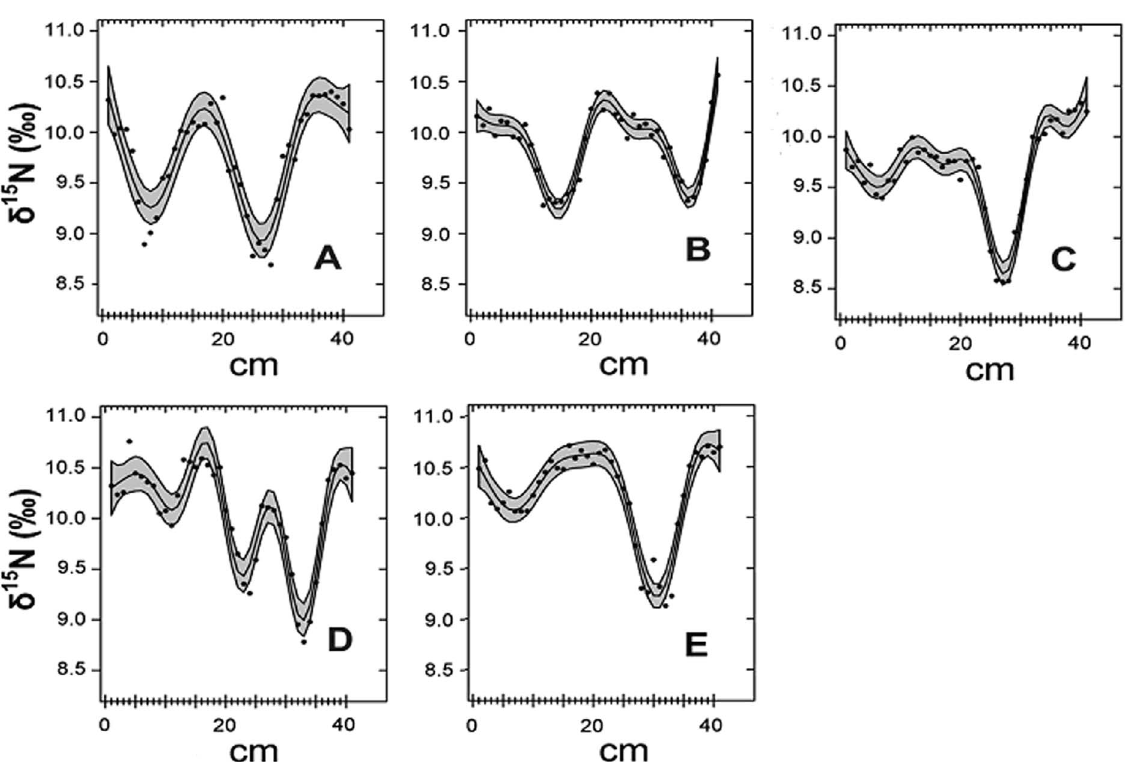
Figure 2. Variation of d 15 N values along the growth axis of the baleen plates (measured in cm from the gum) from the five individuals analysed, identified as A-E. Points depict actual values; the continuous line depicts the fit of the GAM modelling; the blue fringe shows the 95% confidence intervals.